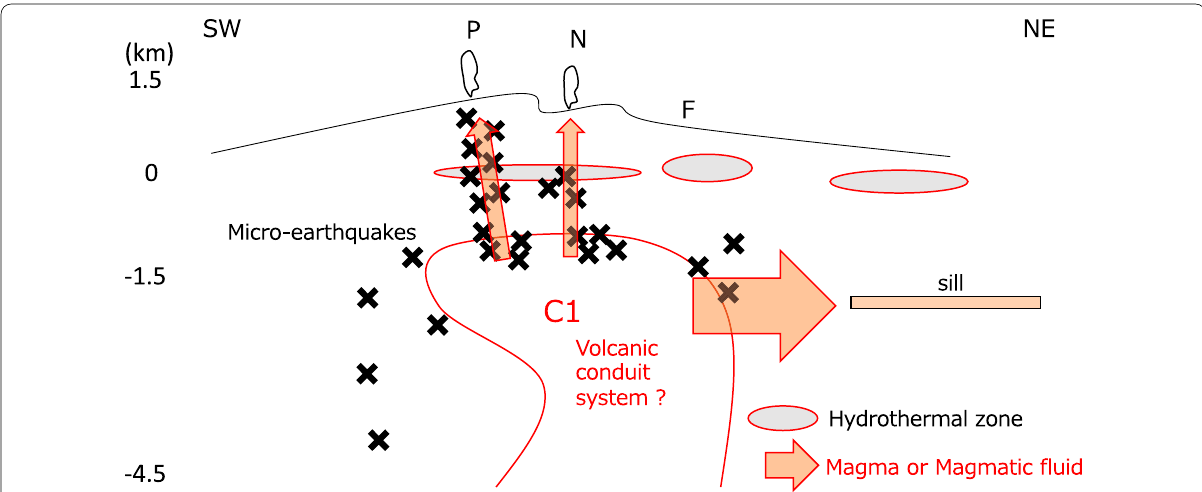
Fig. 5 Conceptual model of the shallow volcanic system of Mt. Meakandake based mainly on our MT model. Crosses indicate microearthquakes. P and N craters are indicated by P and N, respectively. The geothermal area with steaming ground in the middle of the NE flank is shown as